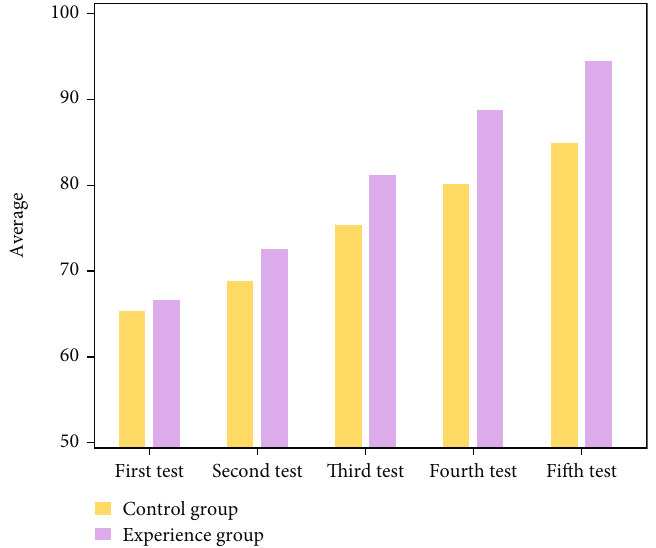
Figure 8: Comparison of average scores of fi ve tests between experimental class and control class.